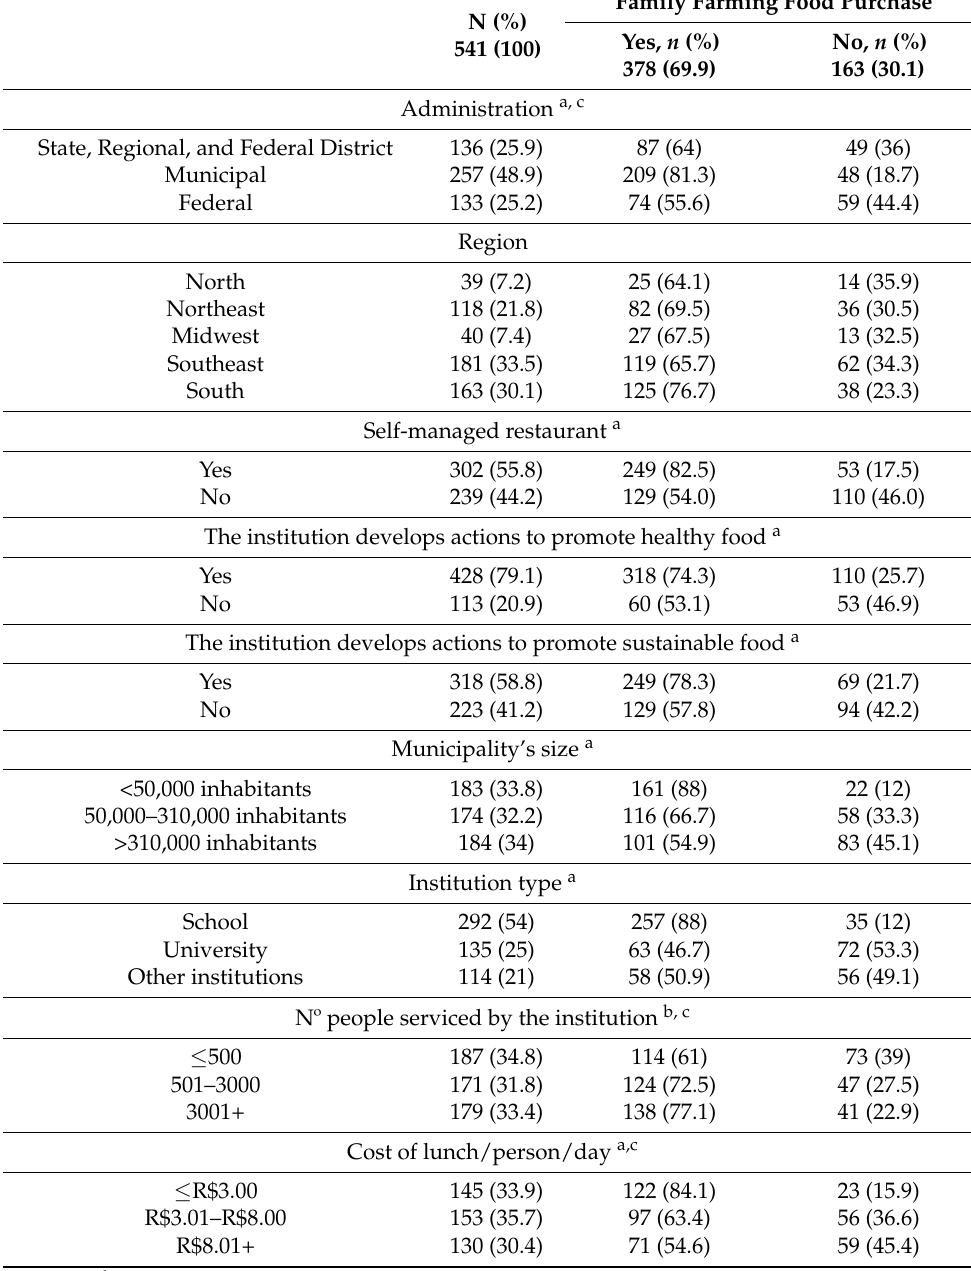
Table 1. Characteristics of public institutional food services in which the study participants operate, stratified according to the local family farmers’ food